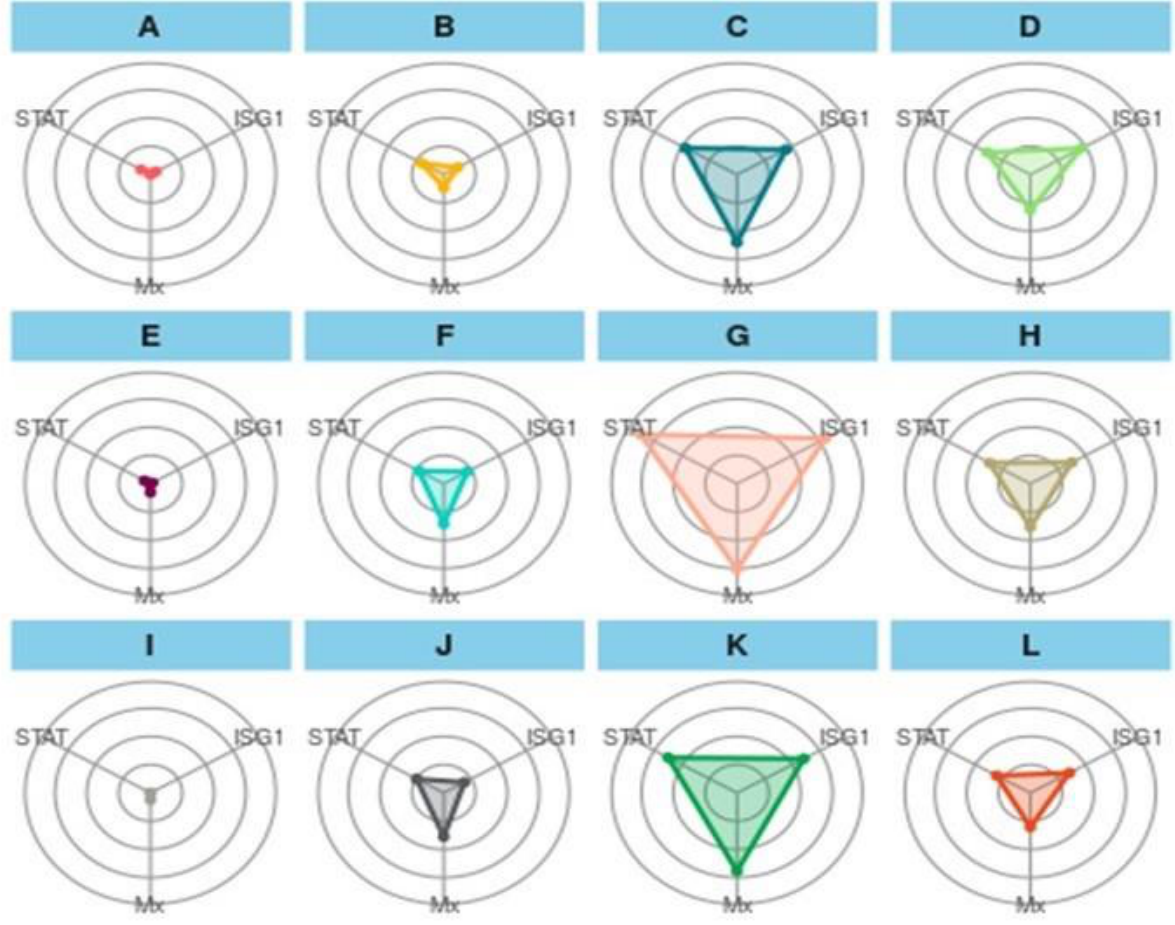
Figure 5. Integrated biomarker response approach plot of gene biomarkers in a feeding trial followed by a challenge study with two bacterial isolates, Edwardsiella tarda and Aeromonas hydrophila , for 10 days (90–100 days). Here, ( A ): CT-90-control treatment at 90 days; ( B ): T1-90-T1 treatment at 90 days; ( C ): T2-90-T2 treatment at 90 days; ( D ): T3-90-T3 treatment at 90 days; ( E ): CT-Ah-Control fish challenge with A. hydrophila at 100 days; ( F ): T1-Ah-T1 fish challenge with A. hydrophila at 100 days; ( G ): T2-Ah-T2 fish challenge with A. hydrophila at 100 days; ( H ): T3-Ah-T3 fish challenge with A. hydrophila at 100 days; ( I ): CT-Et-Control fish challenge with E. tarda at 100 days; ( J ): T1-Et-T1 fish challenge with E. tarda at 100 days; ( K ): T2-Et-T2 fish challenge with E.Tarda at 100 days; ( L ): T3-Et-T3 fish challenge with E. tarda at 100 days. STAT: STAT1 gene; ISG1: ISG